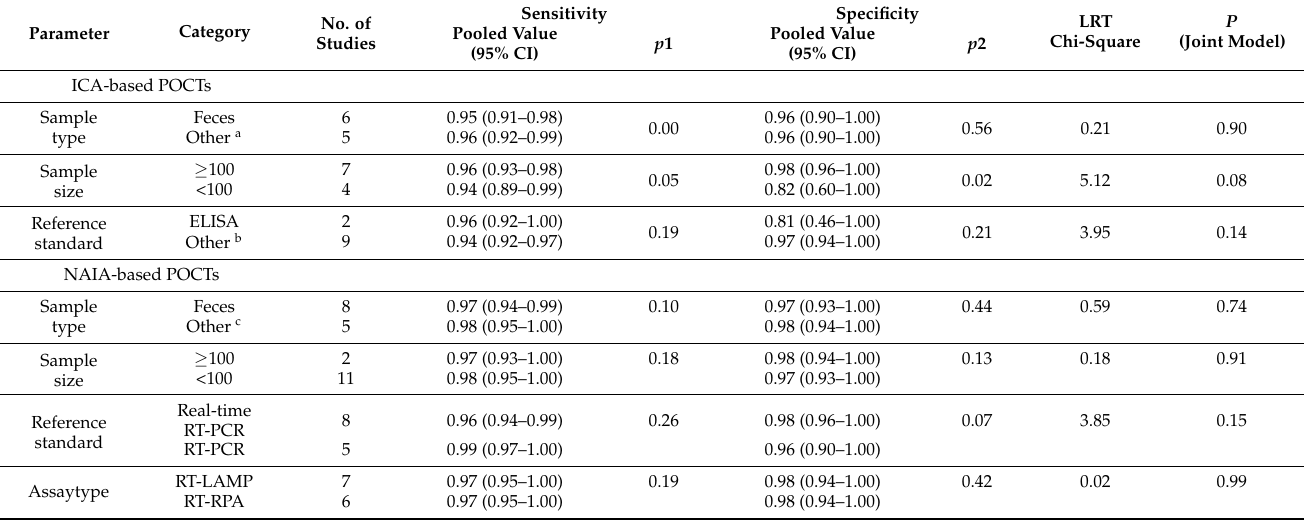
Table 3. Subgroup analysis and meta-regression for the pooled sensitivity and specificity of ICA-and NAIA-based POCTs according to study